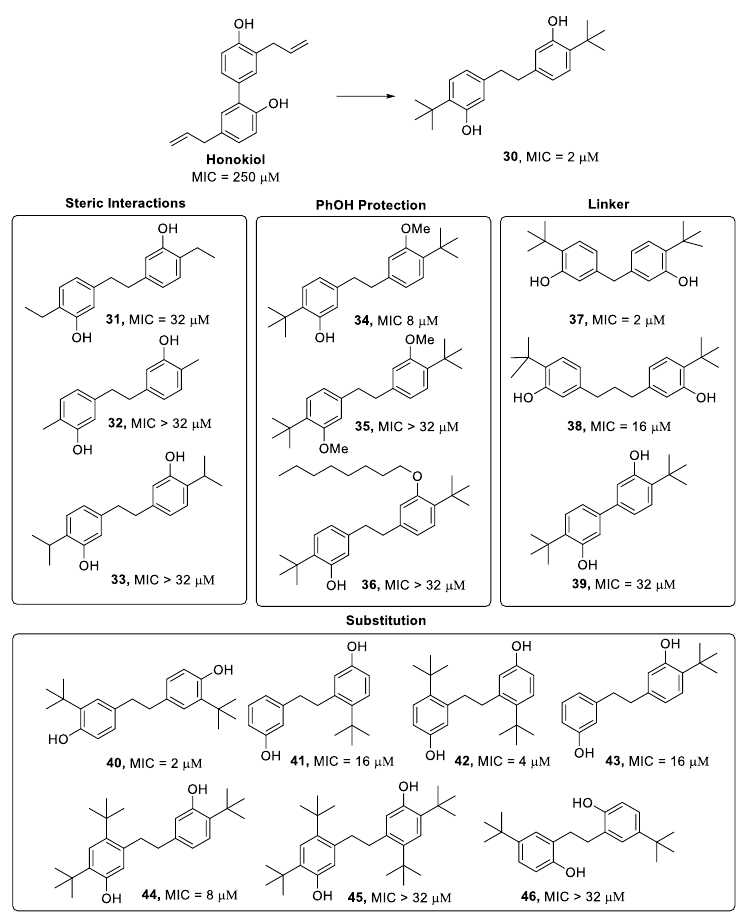
Figure 11. Structures of honokiol and analogues from Solinski et al. (2018) [82] and Ochoa et al. (2020)